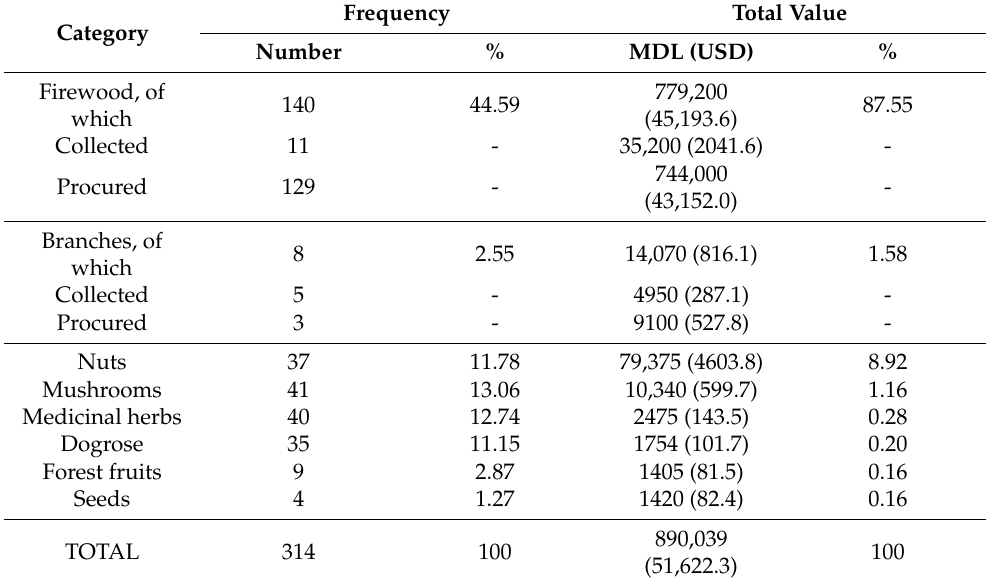
Table 3. Frequency and total value of forest products collected and